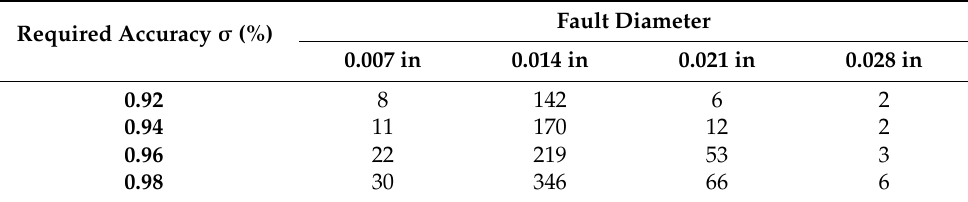
Table 6. The maximum of the sampling number in group B.